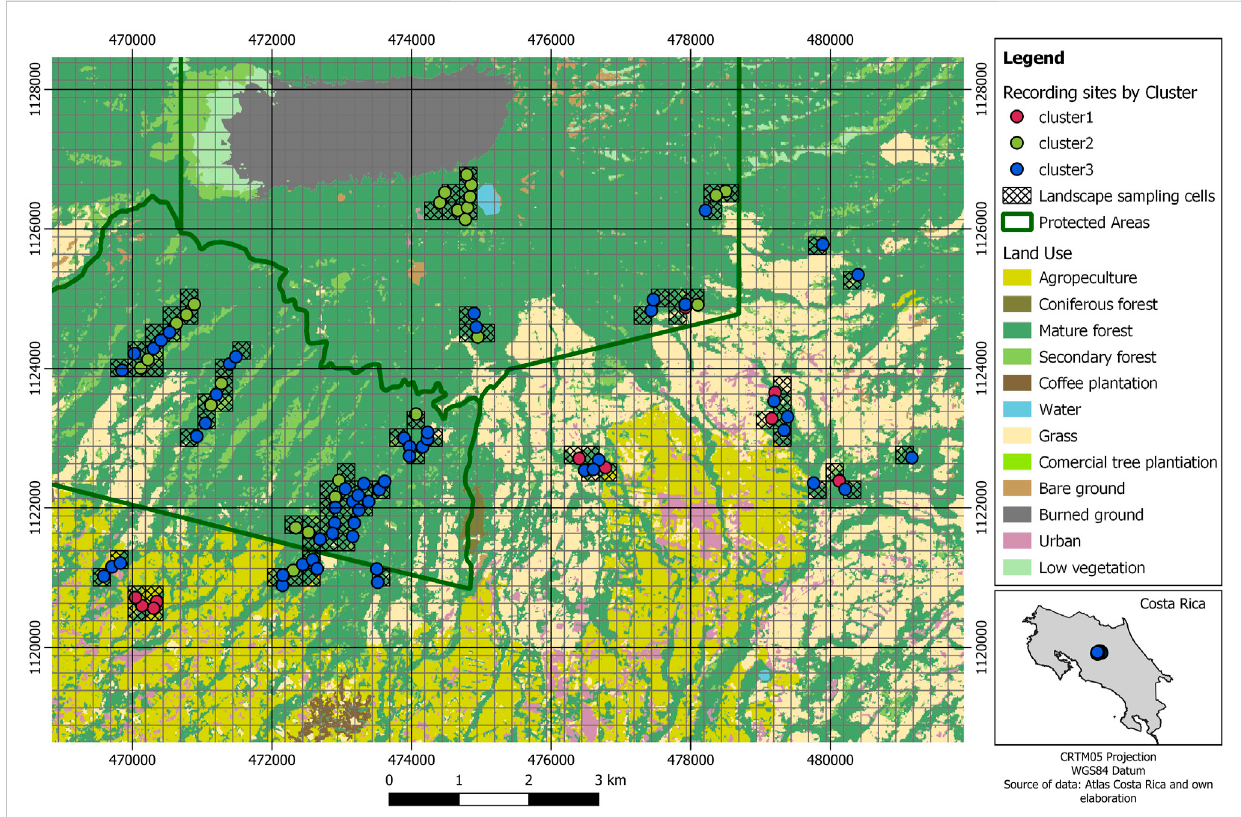
FIGURE 4 Mean values of the landscape variables for every cluster in the Central Conservation Area of Costa Rica, 2019 – 2020. Black lines represent the 95% con fi dence interval for the mean calculation. Y -axes represent the value of the scaled variable, where 0 represents the global mean for all values.